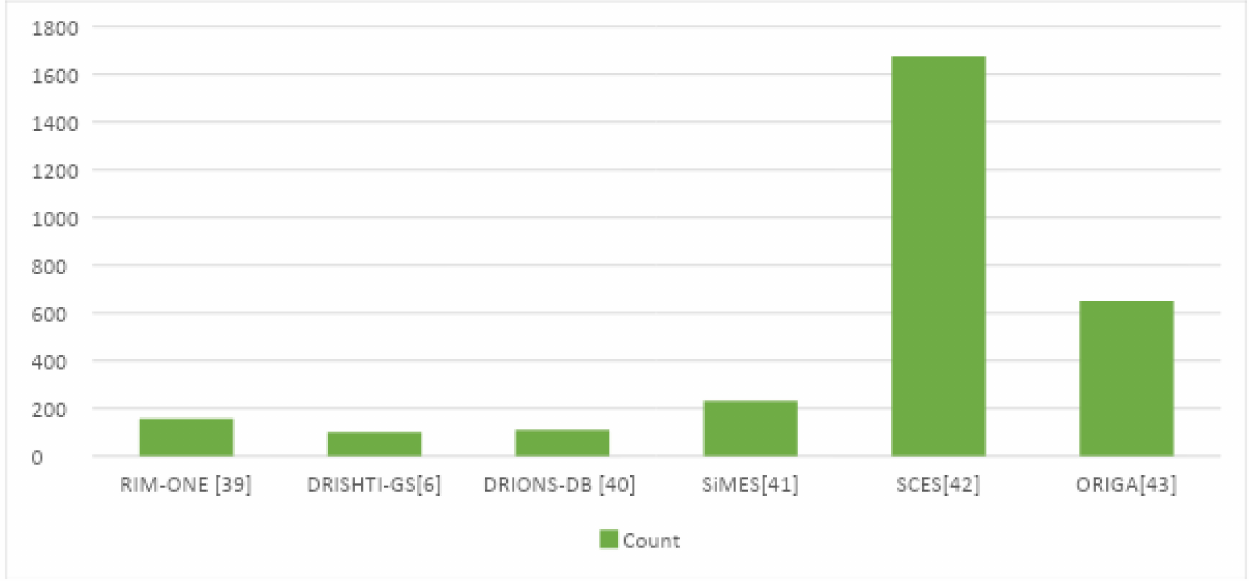
Figure 7. Plot of the available datasets for Glaucoma